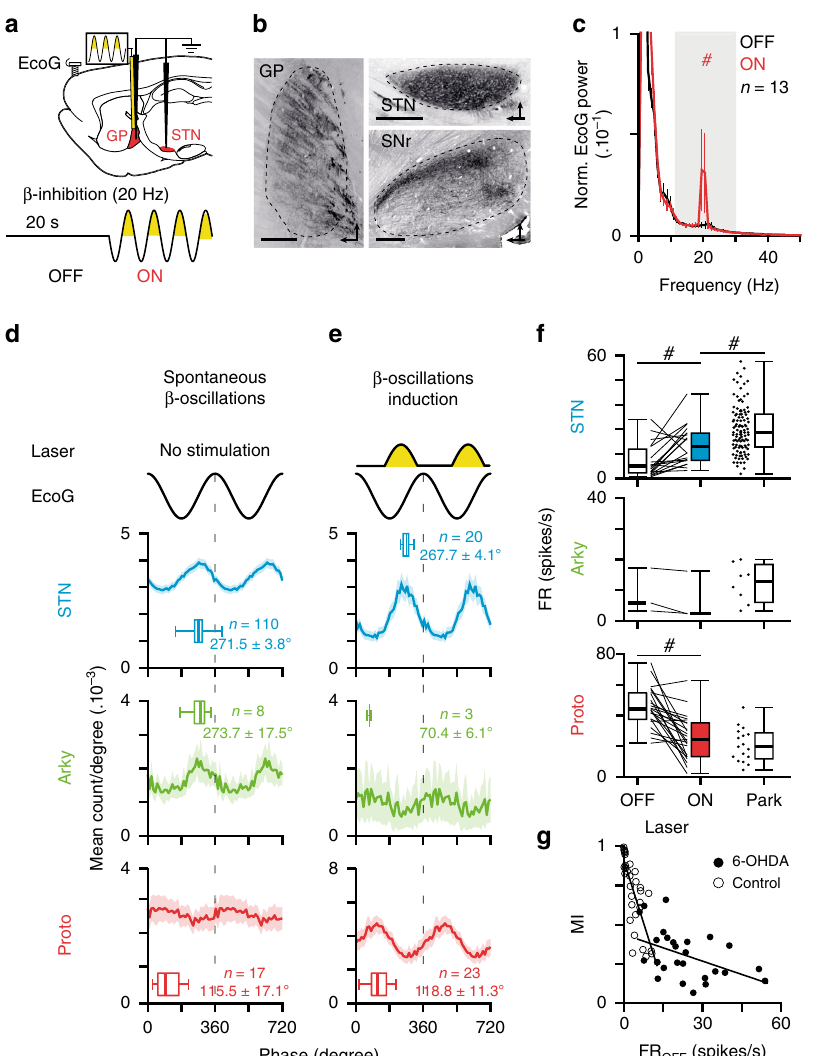
Fig. 6 Optogenetic patterning of GP neurons at β -frequency replicates the core functional properties of parkinsonian β -oscillations. a Schematic of the experiments (top) and laser stimulation protocol used (bottom) to reintroduce abnormal β -oscillations in control rats. b Sagittal epi fl uorescence image of a representative eArch3-EYFP expression in GP (right) and target structures in STN (top left) and SNr (bottom left). Scale bars represent 400 µ m. c Mean normalized power spectrum of mCx ECoG during OFF and ON laser stimulations. d , e Mean phase histograms of STN (top), arkypallidal (middle), and prototypic (bottom) neurons during parkinsonian β -oscillations recorded in PD rats ( d ) or during synthetic β -oscillations generated via GP neurons opto- patterning using eArch3 in control rats ( e ). f Comparison of the fi ring rate changes induced by synthetic β as compared with parkinsonian β in STN, arkypallidal, and prototypic neurons. g Scatter plots and linear regression of the MI versus frequency OFF calculated for all STN neurons recorded in control animals (open circle) or parkinsonian rats (black circle). Group data represents mean ± SEM, box-and-whisker plots indicate median, fi rst and third quartile, min and max values. See also Supplementary Table 6 for statistical